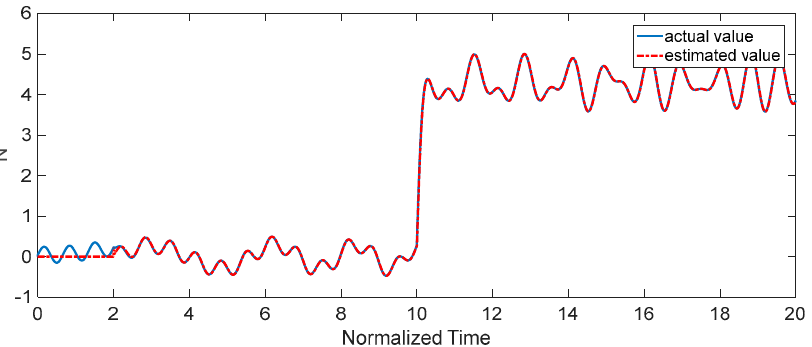
Figure 9. Results of the proposed finite time estimator in the presence of disturbances and faults in